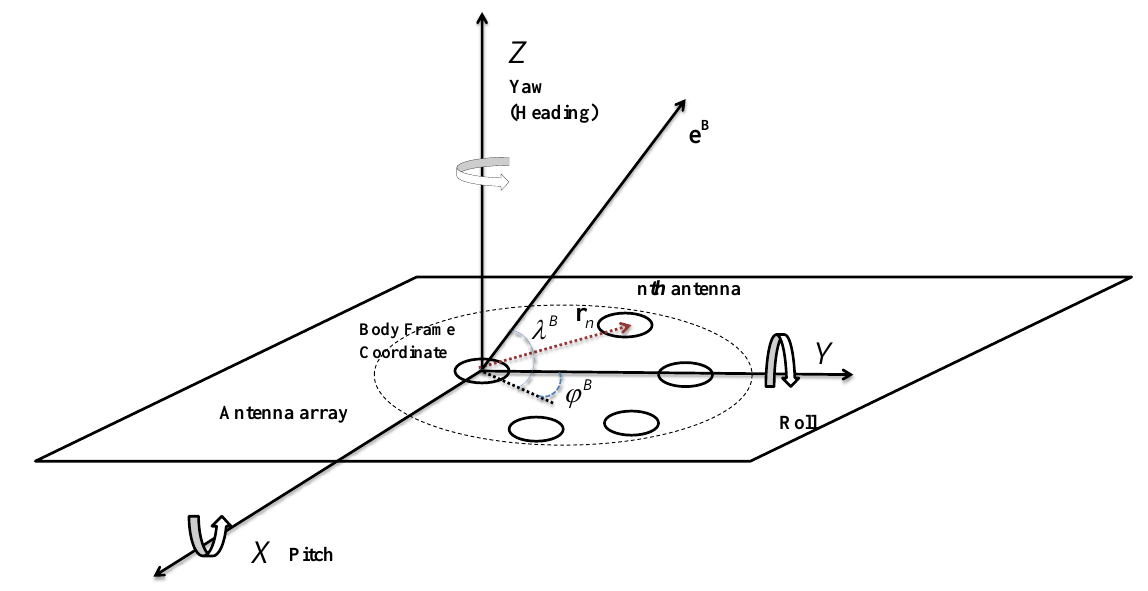
Figure 1. Antenna array configuration in the body frame coordinate